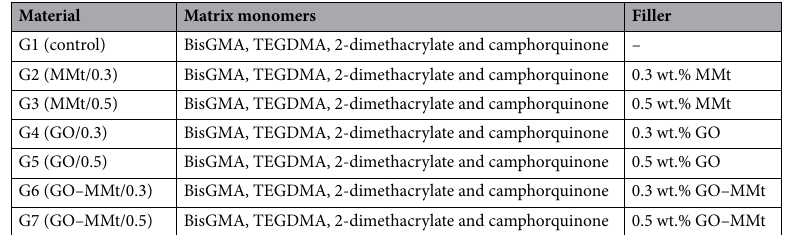
Table 1. Chemical composition of the experimental RBCs. MMt montmorillonite, GO graphene oxide, Bis- GMA bisphenol A-glycidyl methacrylate, TEGDMA triethylene